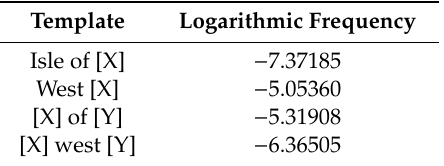
Table 3. Templates and logarithmic frequency (partial). Table 2. Templates and logarithmic frequency